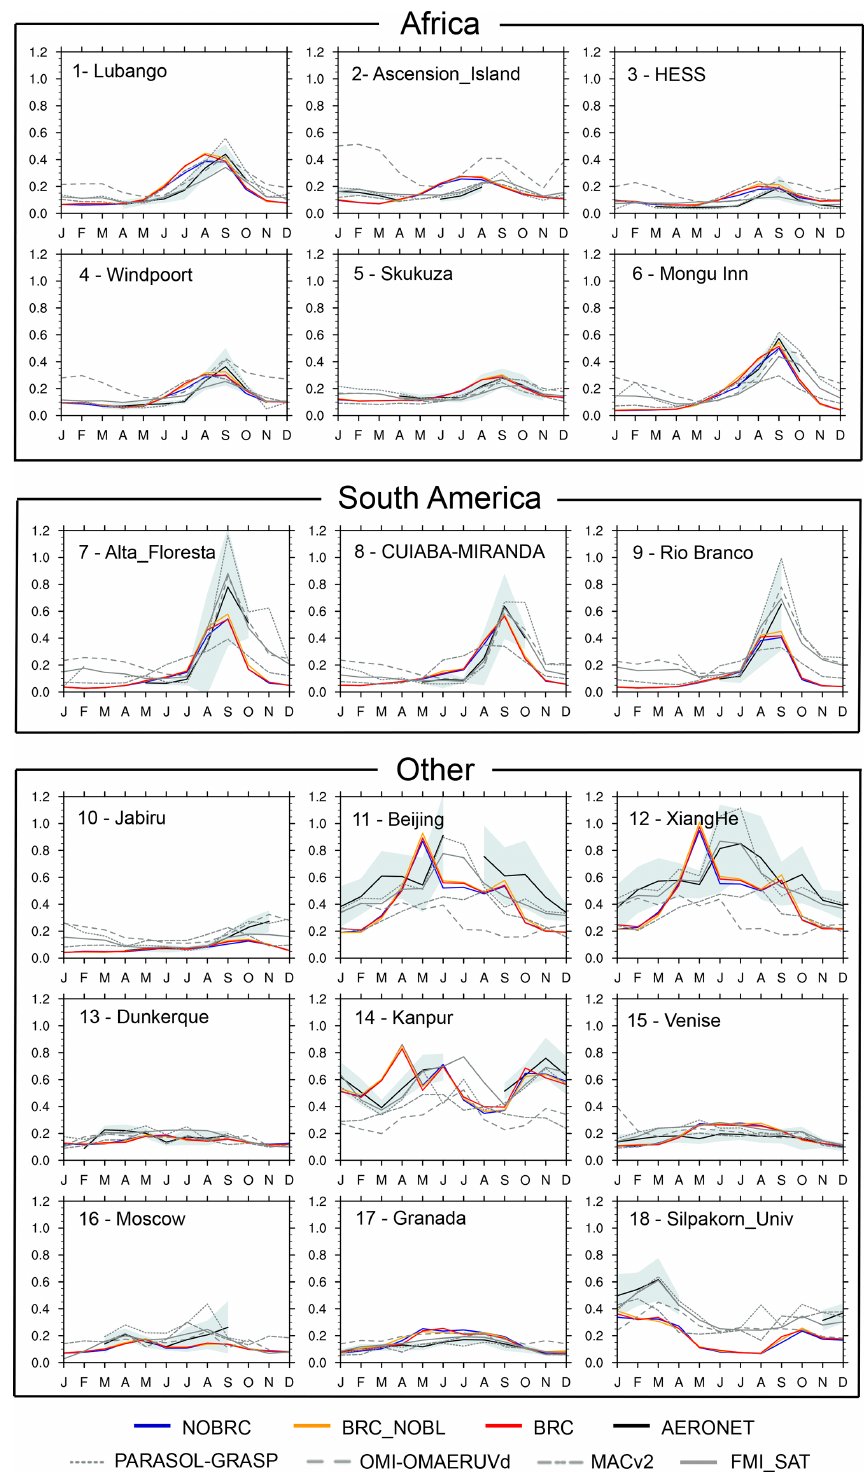
Figure A1. Same as Fig. 3 but for the AOD (550nm; see Tables 2 and 3 for details). FMI_SAT (grey) has been added here.